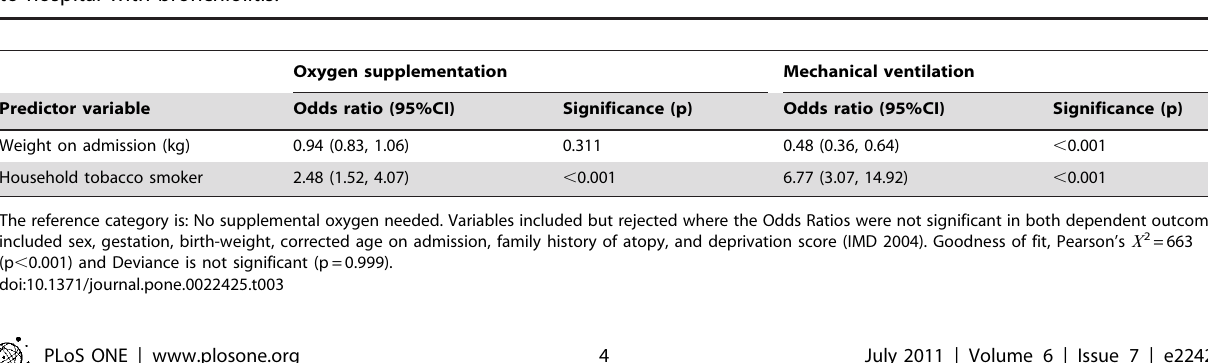
Table 3. Results of multivariate analysis; independent variables predicting severe bronchiolitis in 299 RSV positive infants admitted to hospital with